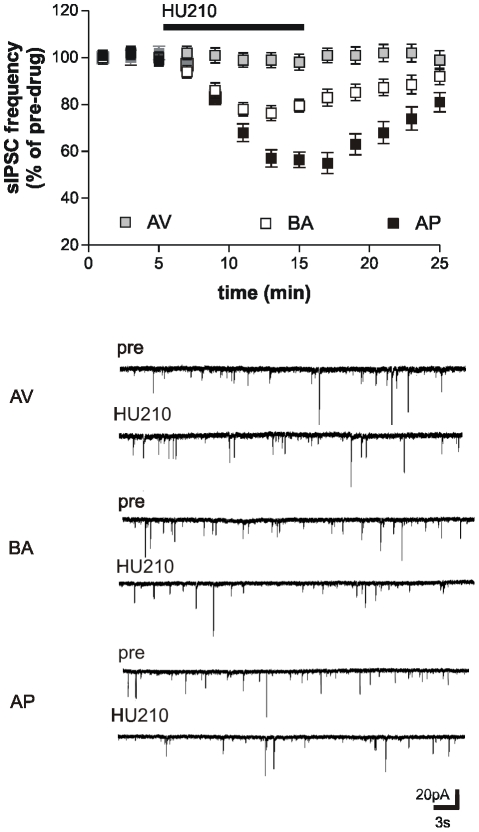
Responses of striatal neurons of avoiding (AV), balancing (BA), and approaching (AP) animals.The graph shows that the sIPSC frequency reduction induced by cannabinoid CB1 receptor agonist HU210 in the BA was potentiated in the AP and abolished in neurons from the AV animals. The electrophysiological traces on the bottom are examples of voltage-clamp recordings before and during the application of HU210 in AV, BA, and AP animals.